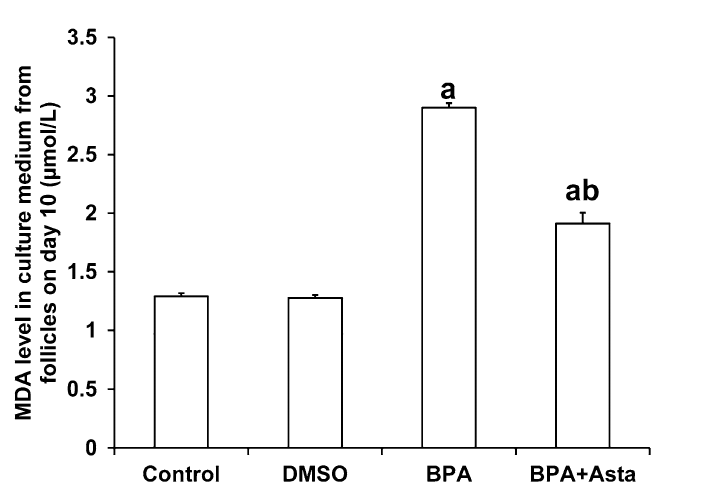
Figure 4. Estrogen and progesterone contents and ERα expression level in cultured D10 follicles. ( A ) The secretion levels of estrogen by D10 follicles (ng/L). ( B ) The secretion levels of progesterone by D10 follicles (ng/ ml). ( C ) The expression levels of ERα in D10 follicular granulosa cells were detected with Western blot analysis. Compared with control, a P < 0.05; and compared with BPA group, b P < 0.05.